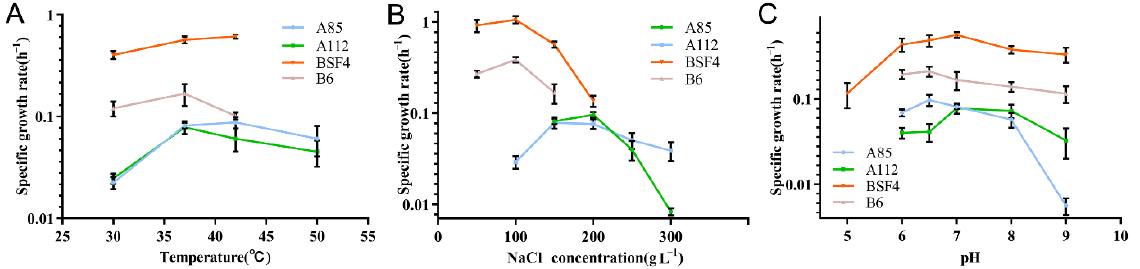
Figure 2. The optimization of the culture conditions for strains A85 (blue line), A112 (green line), BSF4 (orange line), and B6 (pink line). The AS-165 medium was used as the basic medium with specific gradient settings, including: ( A ) temperature (30, 37, 42 and 50 °C); ( B ) salinity (5, 10, 15, 20, 25 and 30%); and ( C ) pH (5, 6, 6.5, 7, 8, and 9). All the data are presented as means of duplicates with their standard errors.